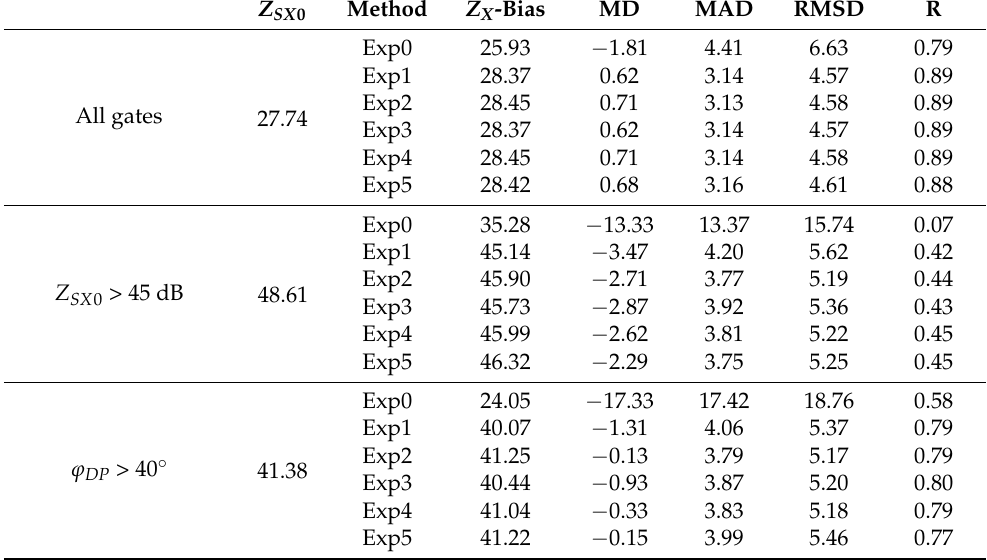
Table 4. Statistical analysis of X-PAR1 errors before and after attenuation correction.